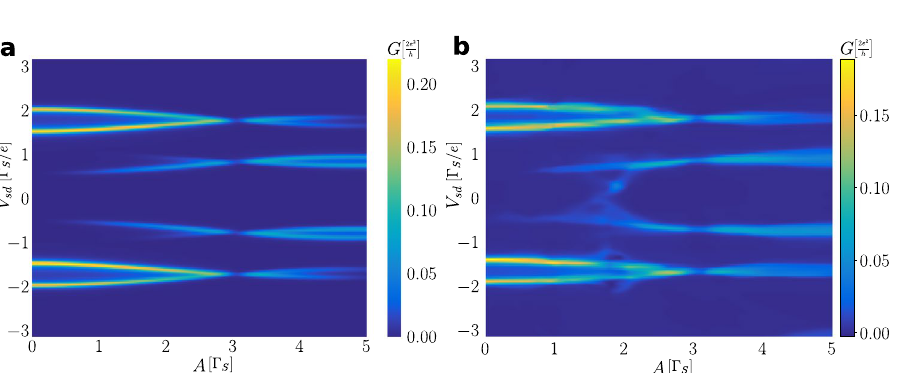
Figure 13. Machine learning results. The conductance map obtained from the microscopic numerical calculations ( a ) and generated by the neural network ( b ) for V 12 not been used for learning the neural